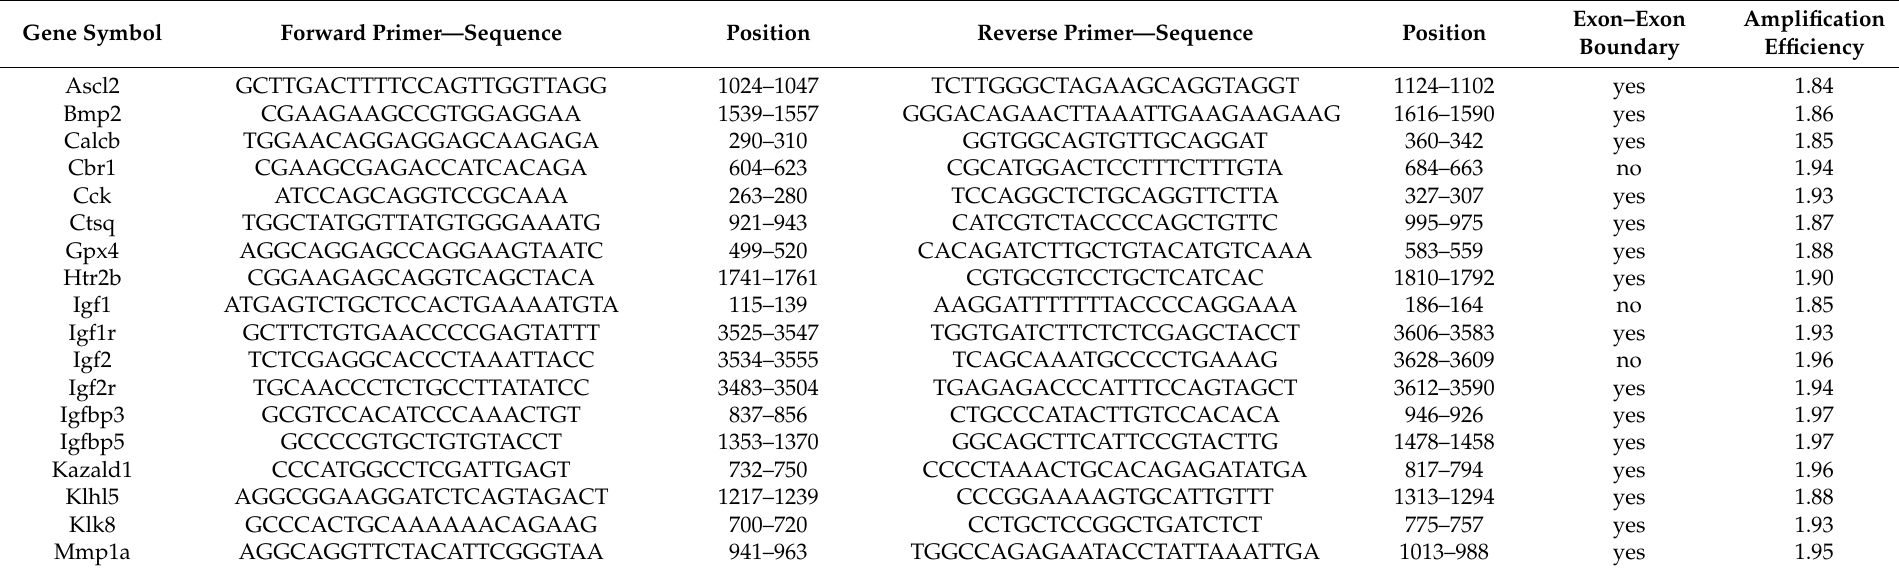
Table 1. PCR primers employed in this study and their amplification efficiencies. Gene symbols follow the Mouse Genome Informatics (http://www.informatics. jax.org accessed on 31 October 2021) nomenclature: Ascl2: Achaete-scute family bHLH transcription factor 2; Bmp2: Bone morphogenetic protein 2; Calcb: Calcitonin- related polypeptide, beta; Cbr1: Carbonyl reductase 1; Cck: Cholecystokinin; Ctsq: Cathepsin Q; Gpx4: Glutathione peroxidase 4; Htr2b: